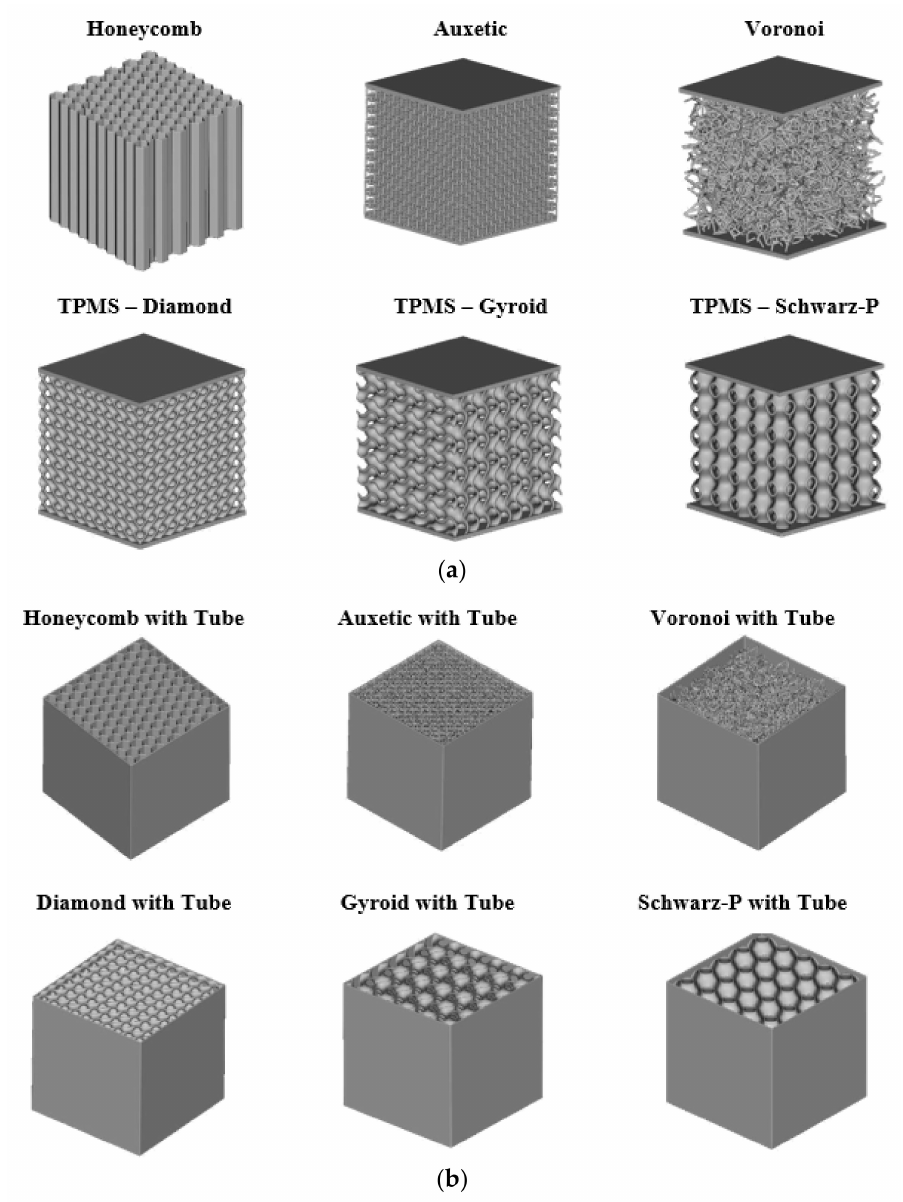
Figure 2. Design of cellular structures used in this study: ( a ) the six-unit cell shapes used in this study, ( b ) the same shapes enclosed in a 0.5 mm thin